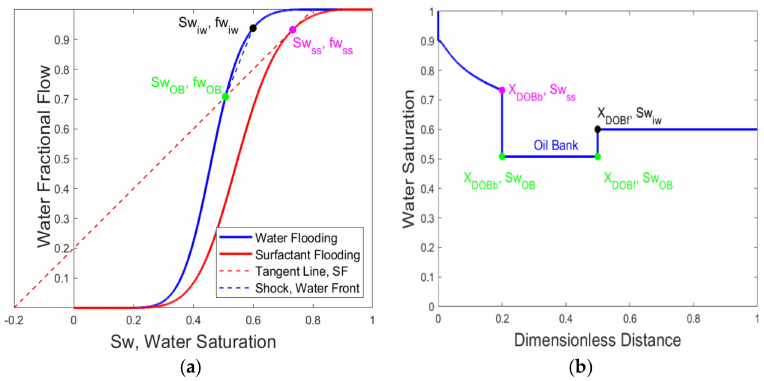
Figure 9. ( a ) Construction of shock front; and ( b ) water saturation profile at t D = 0.2 PV during continuous surfactant injection, with adsorption, D i = 0.20 PV, no partition. PV: pore volume.